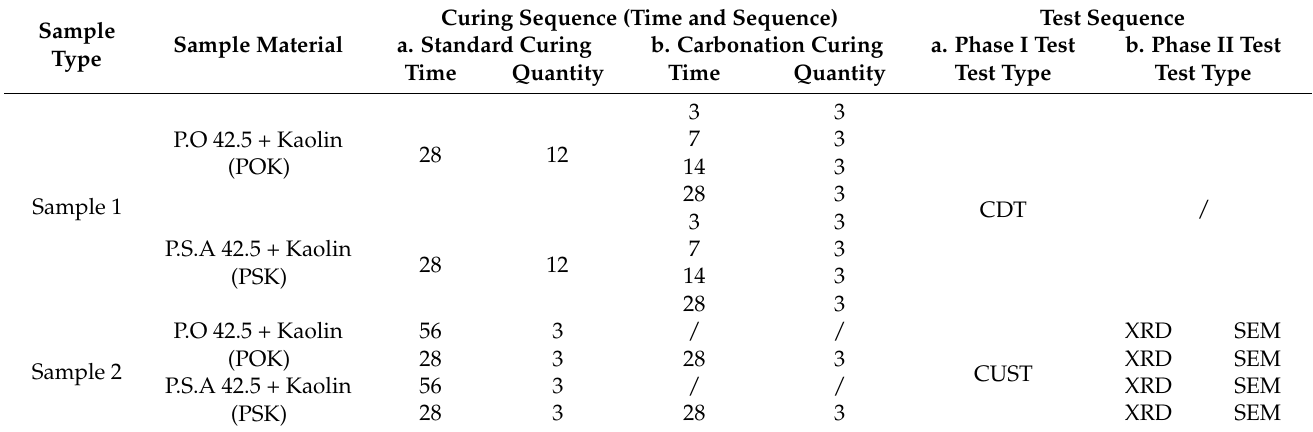
Table 2. Sample preparation and test